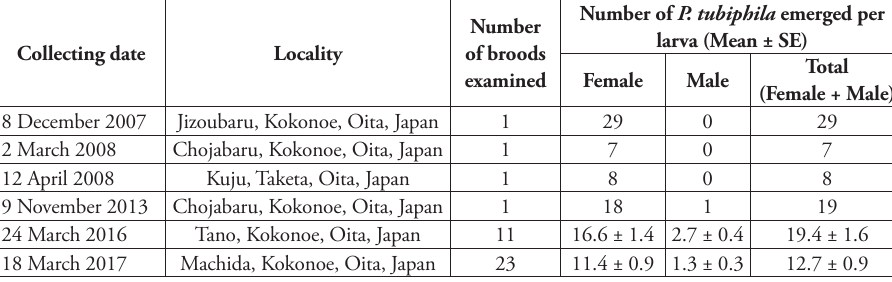
Table 1. Reproduction by Platygaster urniphila : the number of adults emerged from a single larva of Rhopalomyia longitubifex